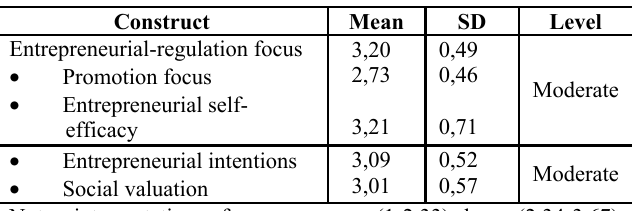
Table 1: Means, standard deviations and levels of the study variables